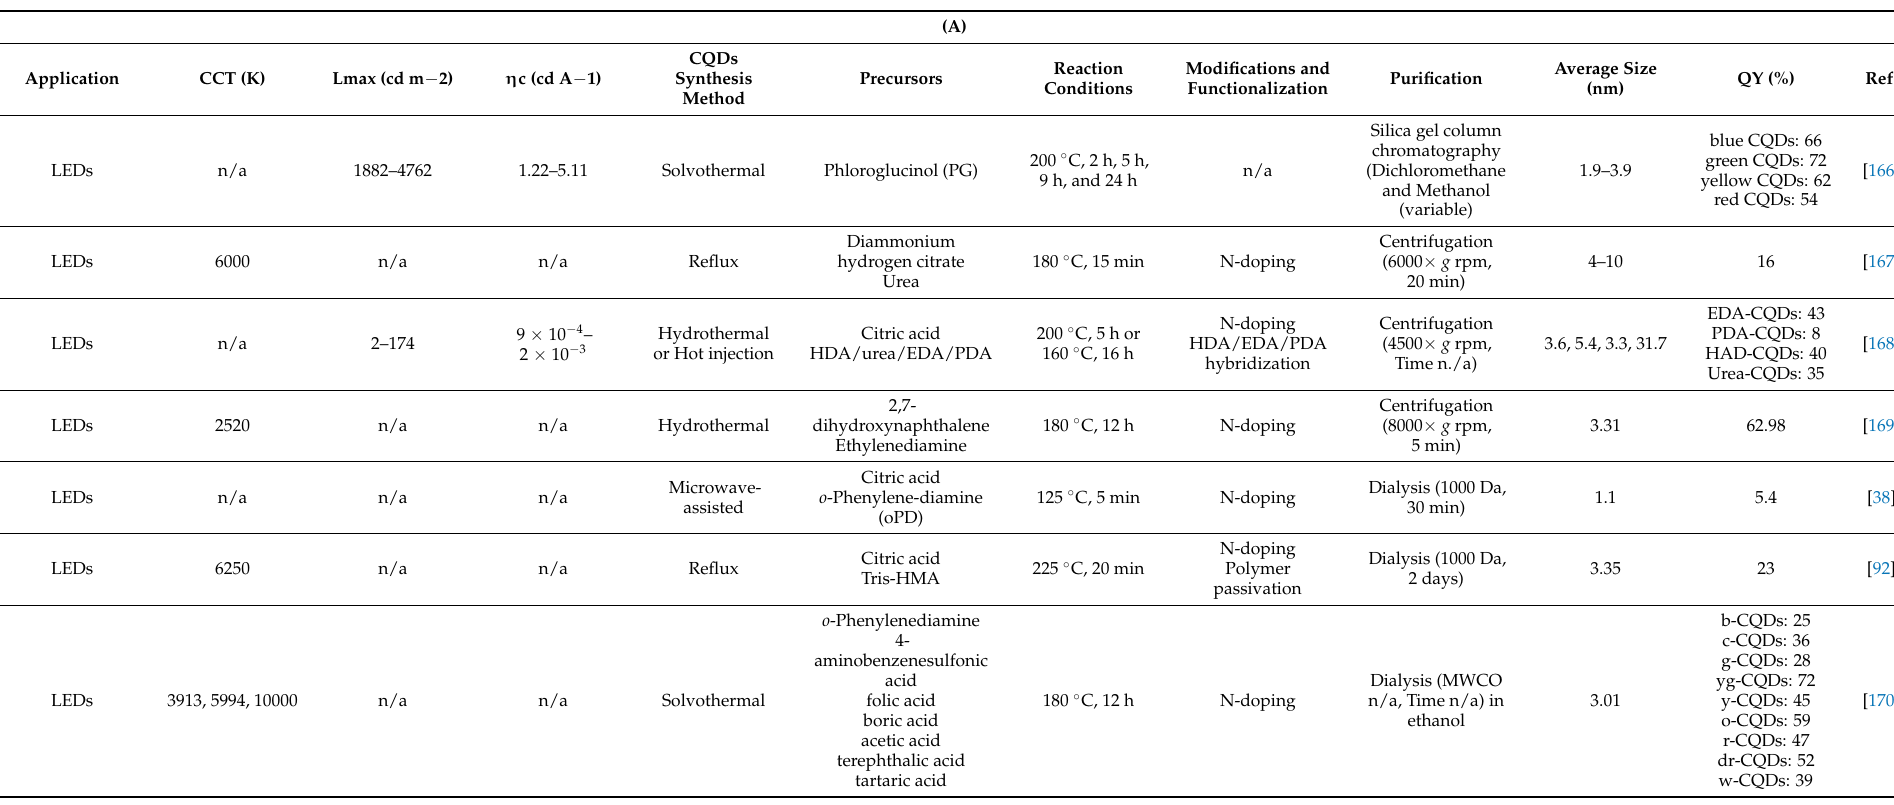
Table 5. ( A ) summarized examples of carbon quantum dots used for optoelectronics—LEDs. ( B ) Summarized examples of carbon quantum dots used for optoelectronics–Solar converters.